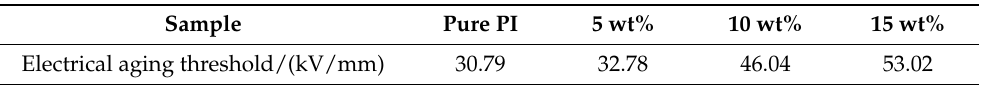
Table 1. Electrical aging thresholds of pure PI films and PI/SiO 2 three-layer composite films with different doping